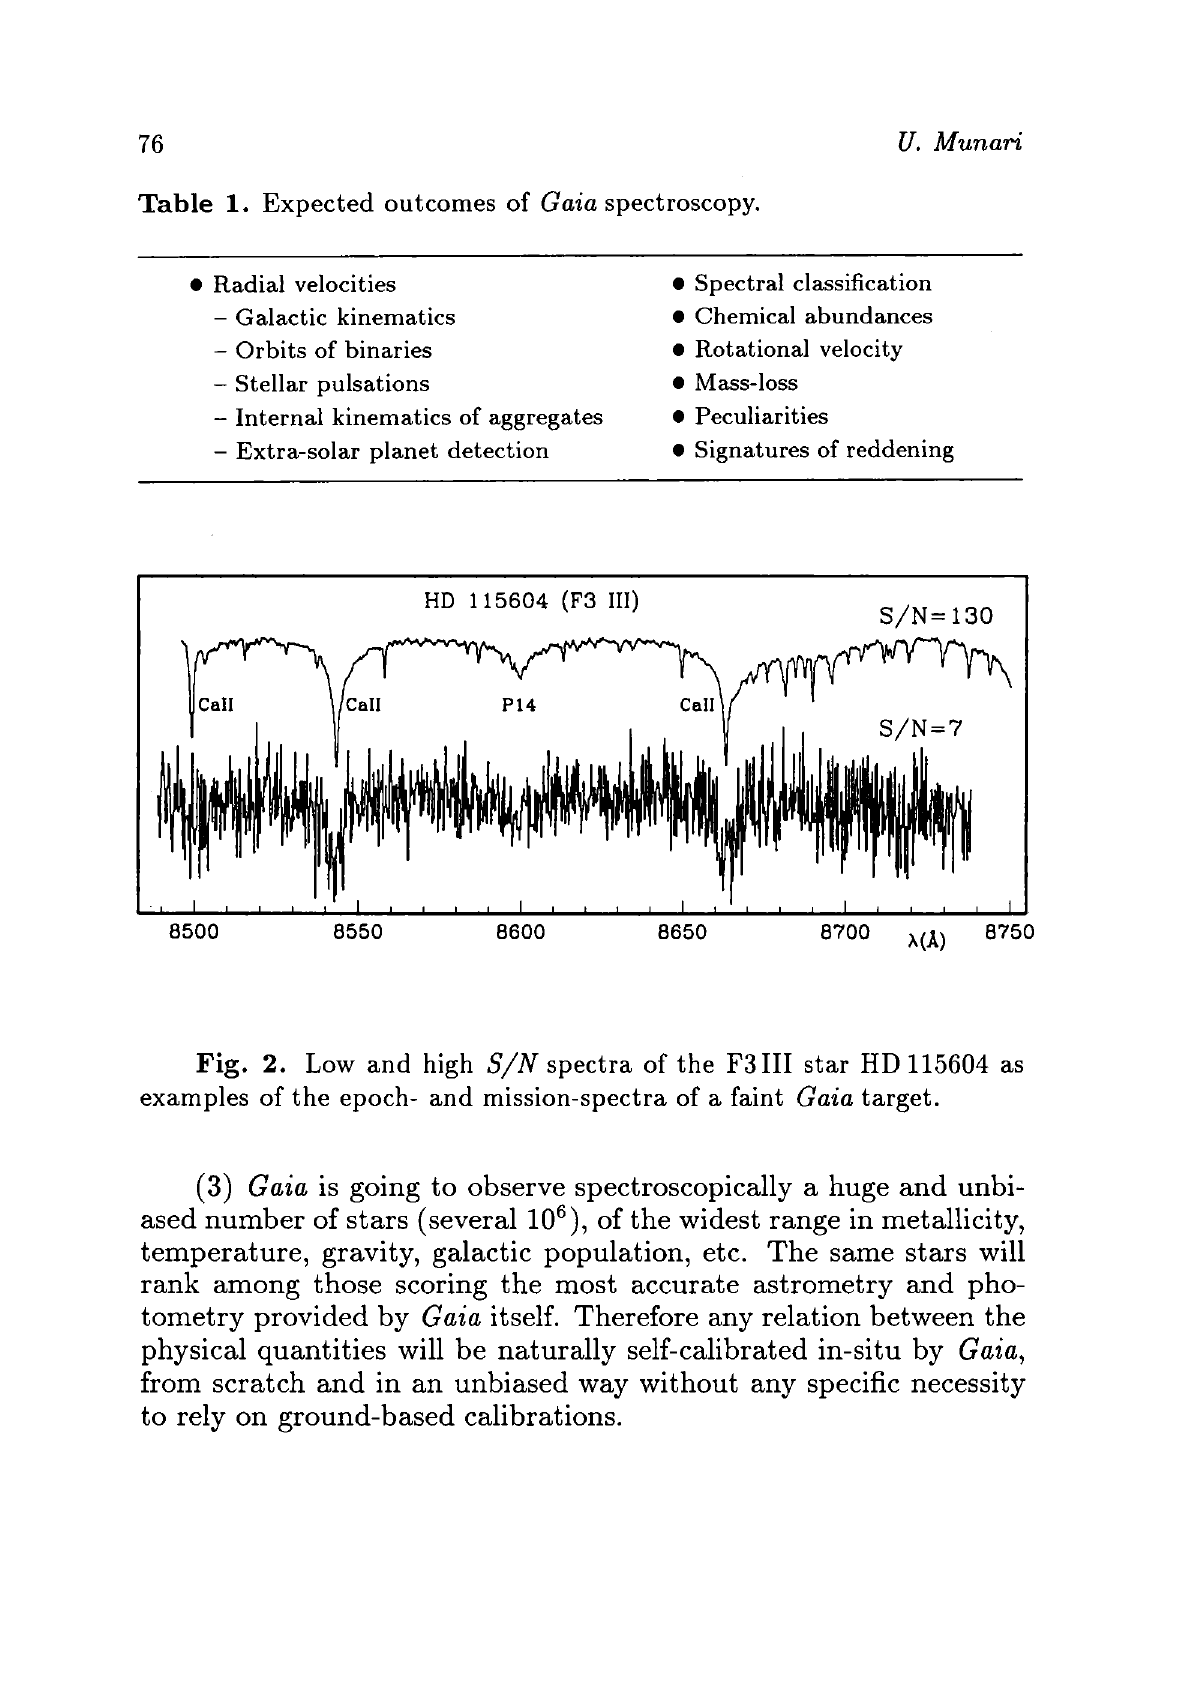
Table 1. Expected outcomes of Gaia spectroscopy.